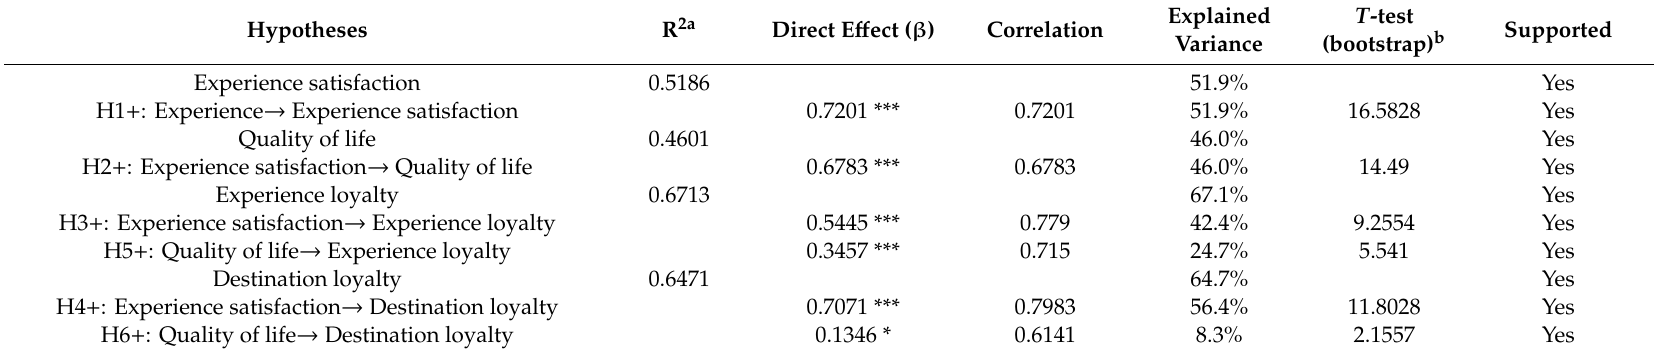
Table 9. E ff ects on endogenous variables and structural model